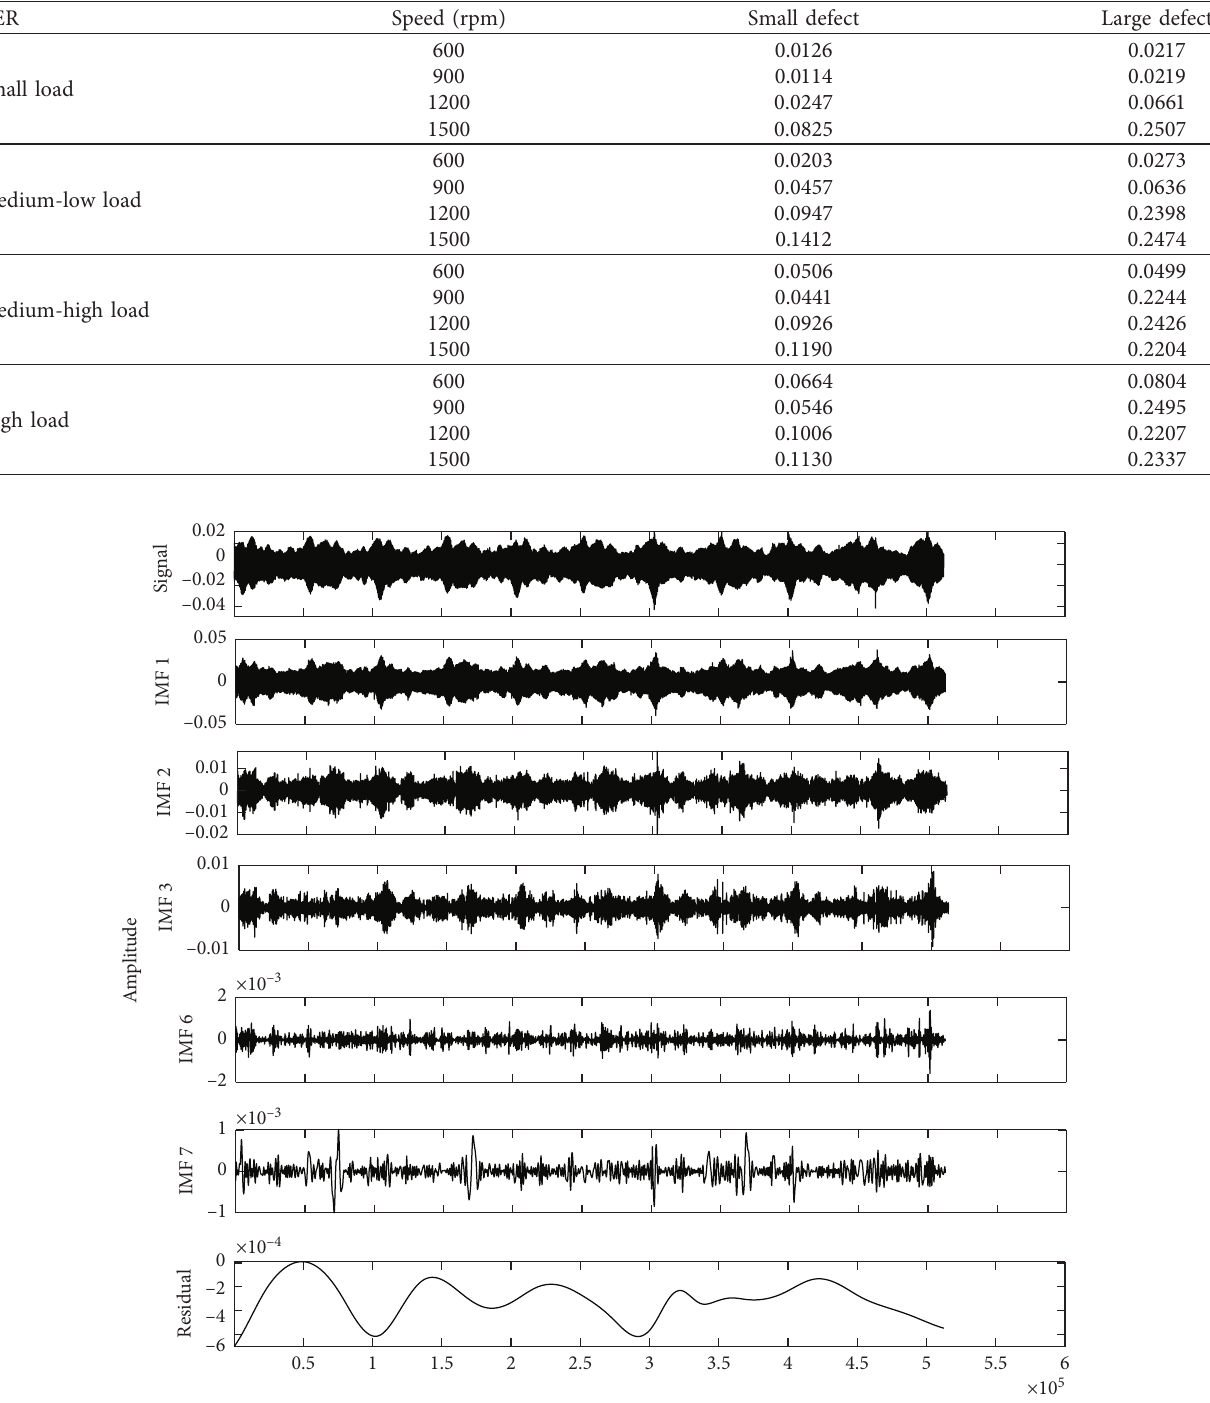
Figure 8: Decomposition of the signal into different